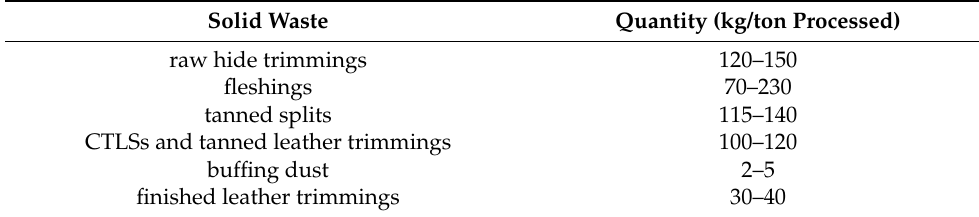
Table 2. Quantity of solid waste produced from 1 ton of raw hide